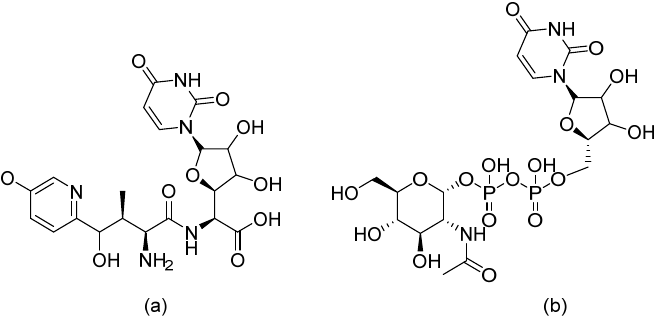
Figure 6. The chemical structures of ( a ) Nikkomycin Z and ( b ) Uridine Diphosphate (UDP)- N -acetyl glucosamine.